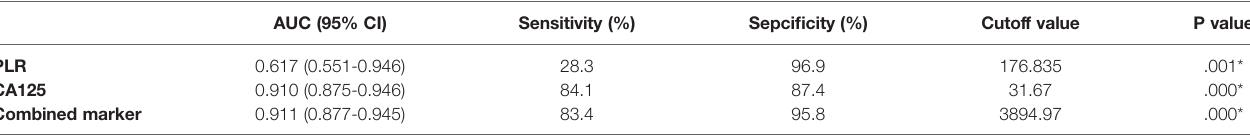
TABLE 2 | Sensitivity and Speci fi city of CA125, PLR, and Combined Marker for Detection of Ovarian